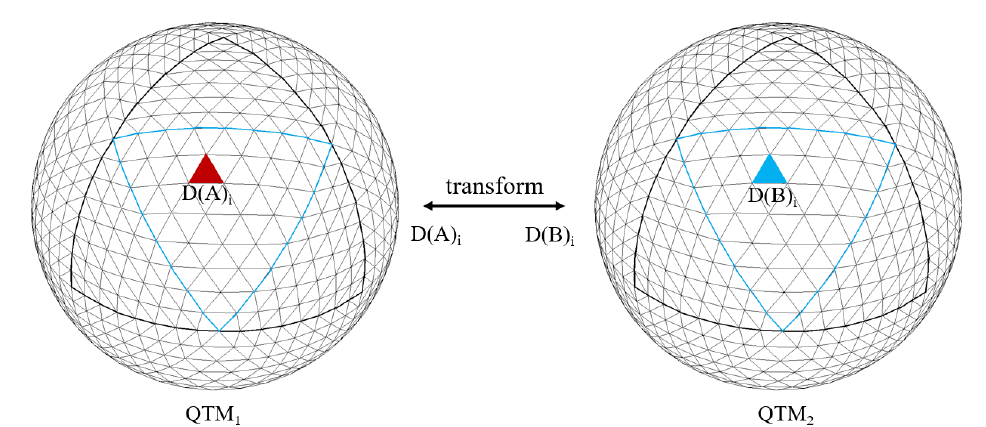
Figure 9. Encoding conversion diagram of QTM 1 and QTM 2 .